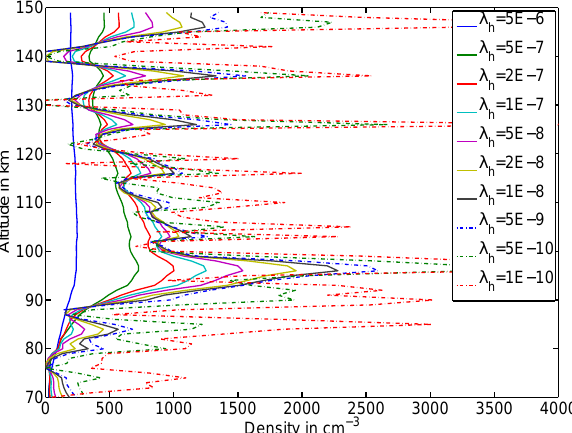
Fig. 27. Result for Mg + (280.4nm) for the same conditions as in Fig. 26.